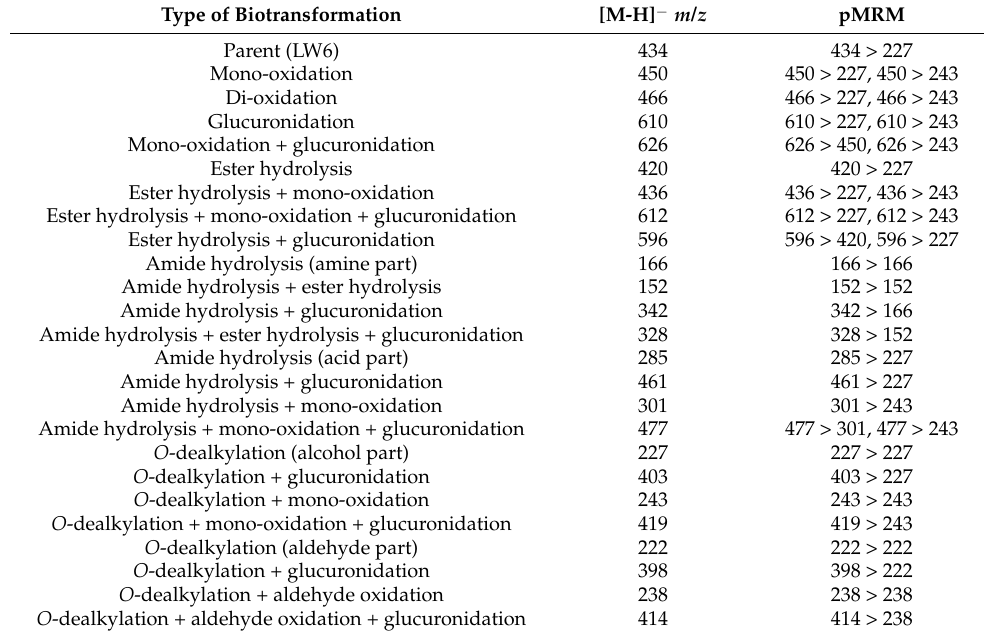
Table 3. List of biotransformations for profiling of LW6 and its metabolites in mice. Type of